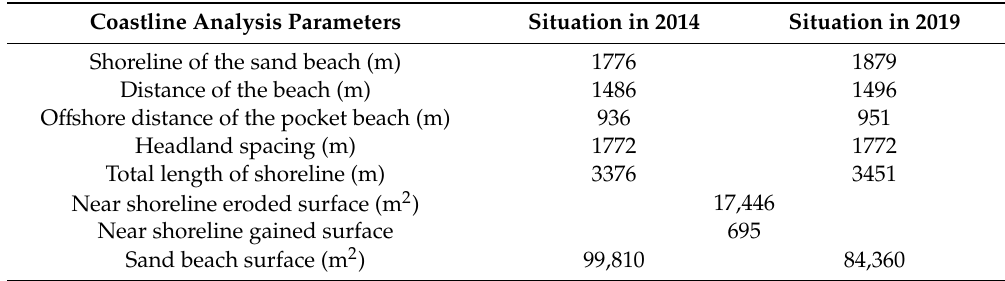
Table 5. Coastline changes on the pocket beach of San Vito Lo Capo from 2014 to